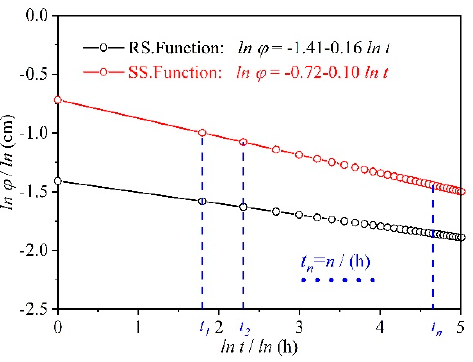
Figure 11. Logarithm of the effective penetration radius ( ln φ ) as a function of logarithm of the seepage time ( ln t ).